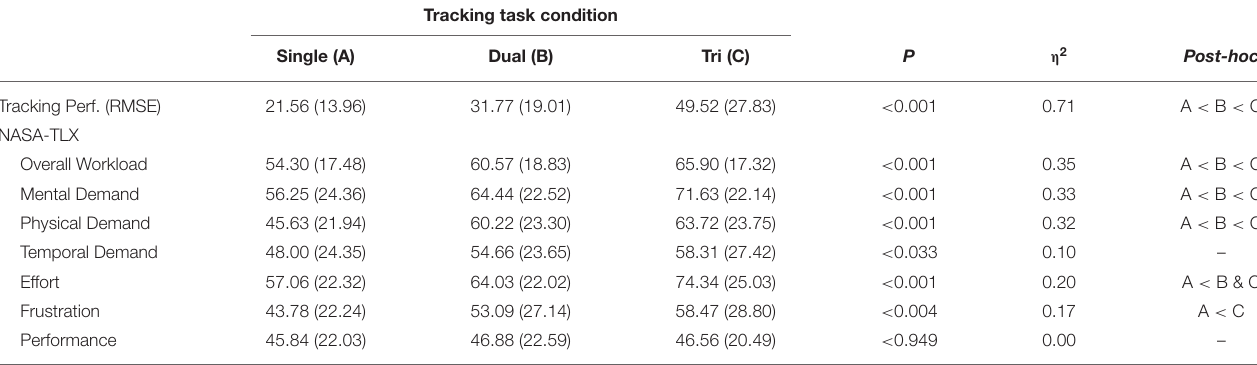
TABLE 2 | Means (and standard deviations) for tracking performance on the Multi-Attribute Task (MAT) and workload ratings on the NASA-TLX in adults with